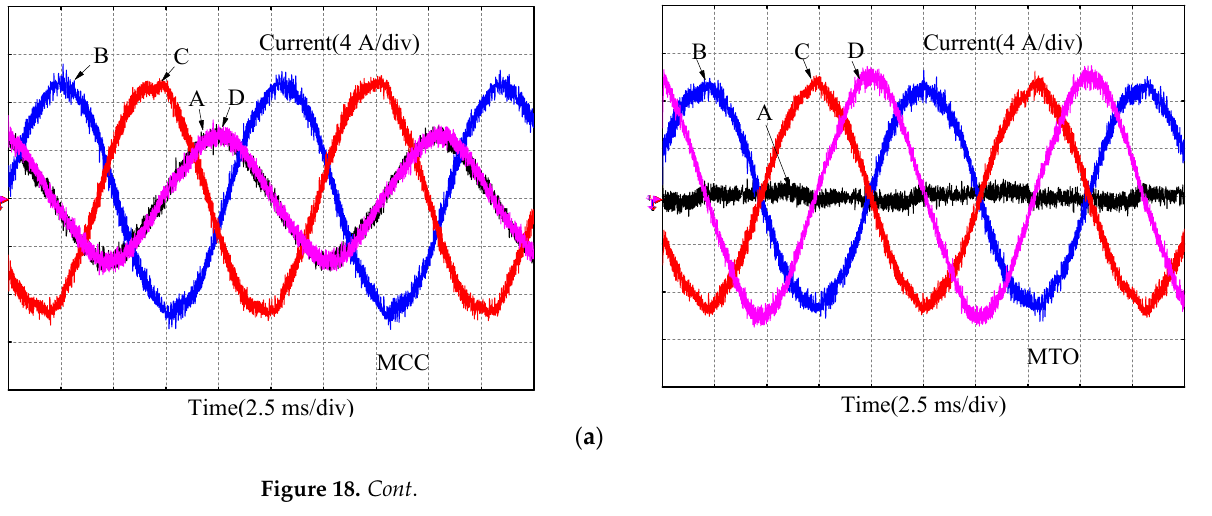
( b ) Figure 18. Motor waveform with fault-tolerant control. ( a ) Current waveform. ( b ) Speed wave- form. 7. Conclusions In this paper, a high-performance fault-tolerant control strategy with model predic- tion is proposed to reduce the total harmonic distortion of DTP-PMSM drives. The contri- butions of the study are concluded as following.